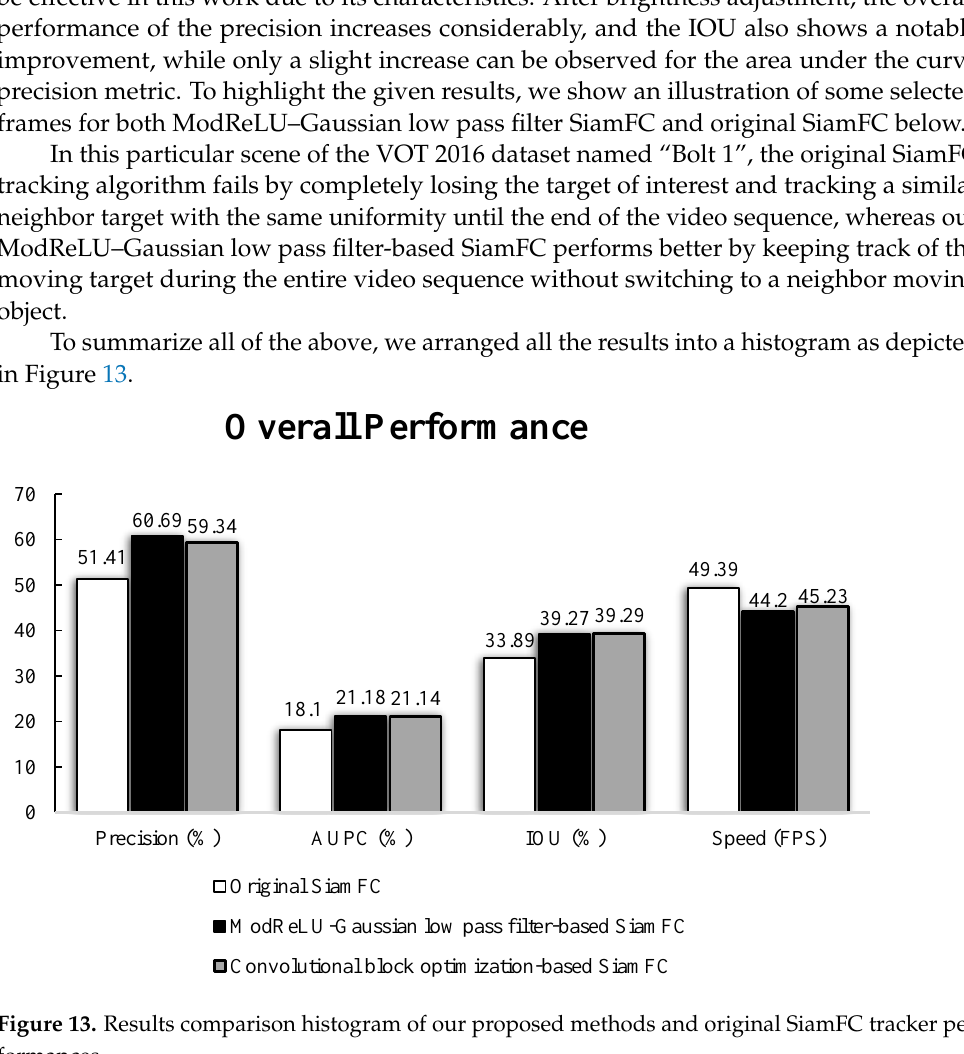
Table 7. Comparison results under precision and speed (FPS) with top performers on the VOT2016. The top two outcomes are highlighted in red and blue.